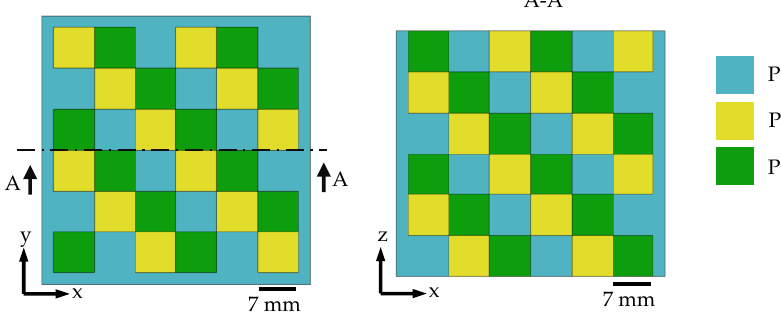
Figure 3. Arrangement of the parameters within the large cube.